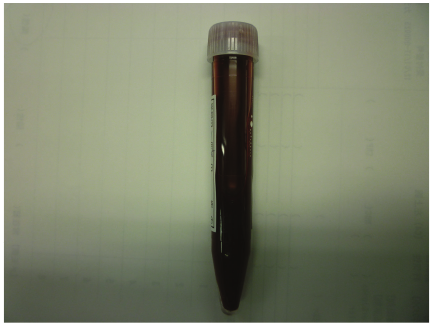
Figure 3: At postoperative day 27, we punctured the hematoma and 150 grams of uncoagulated bloody liquid was